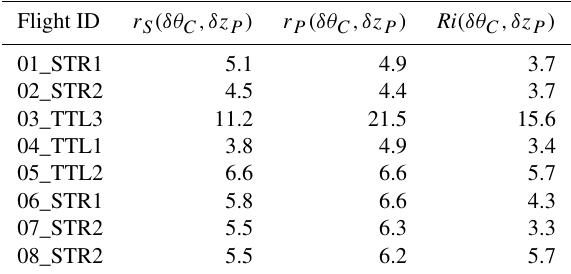
Table 5. Fraction of time (percent) during which the flow is found to be turbulent. Turbulence is diagnosed from the correlation method based of δθ C and δz P (second and third columns) and from the Ri (δT C ,δz P ) criterion (last